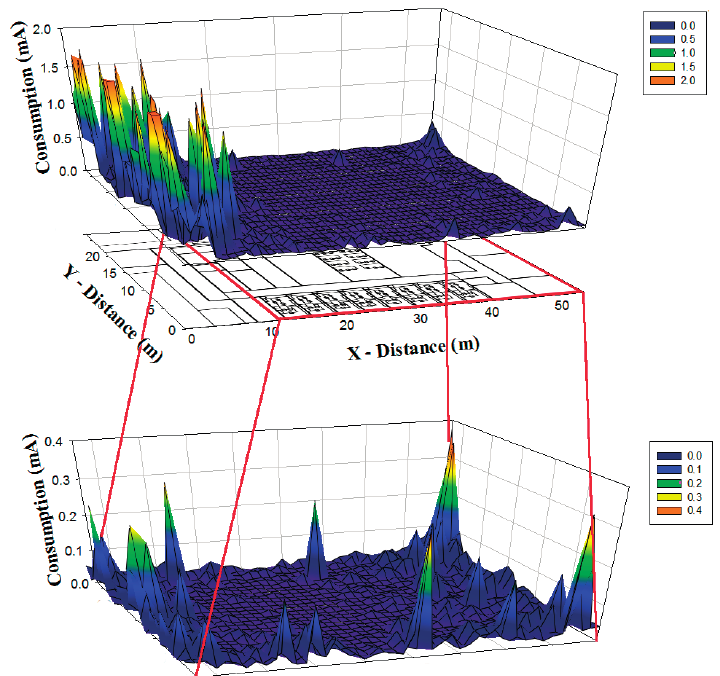
Figure 12. Estimation of Energy consumption for the antenna 3 in terms of current values in mA for different receiver locations within the scenario at height 1 m.